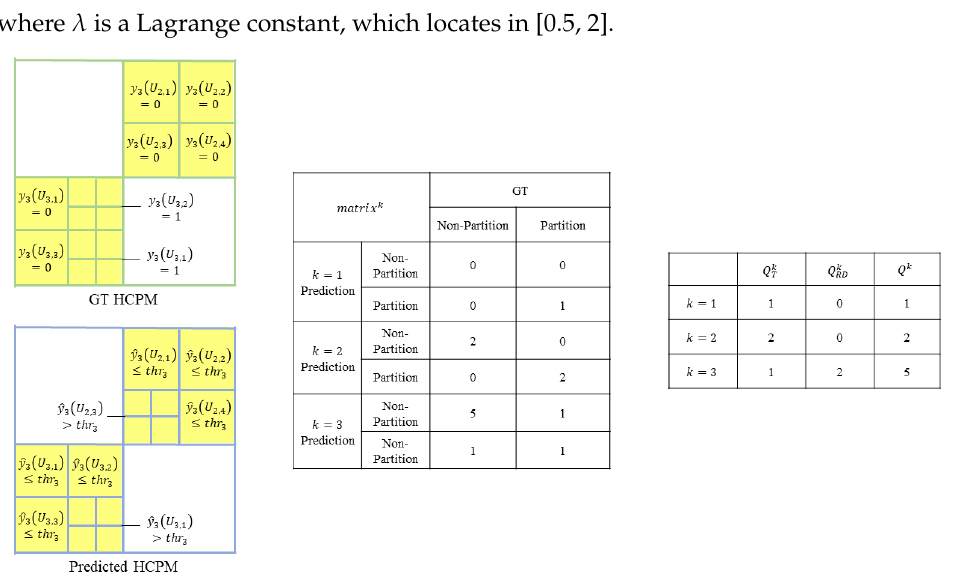
Figure 4. An example of the RD memory computation. The RD memory aims to record the difference between ground truth HCPM and network results. The corresponding partition results of different levels of CU blocks are recorded in matrix k . Q k can be calculated from matrix k for three partition